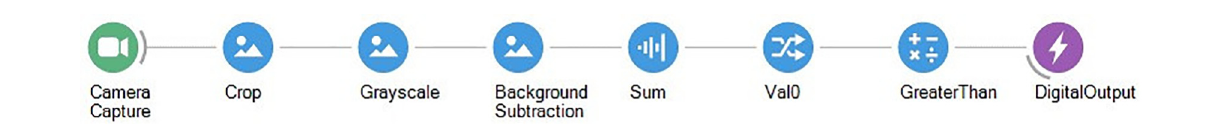
FIGURE 10 | Bonsai workflow for triggering a digital output based on